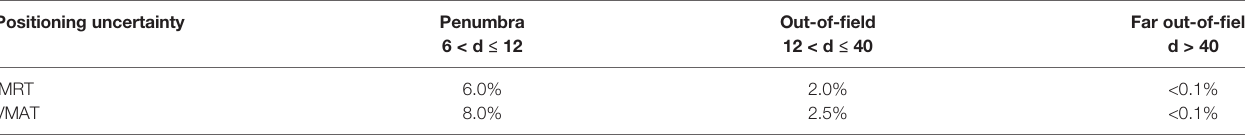
Distance d to isocenter is expressed in